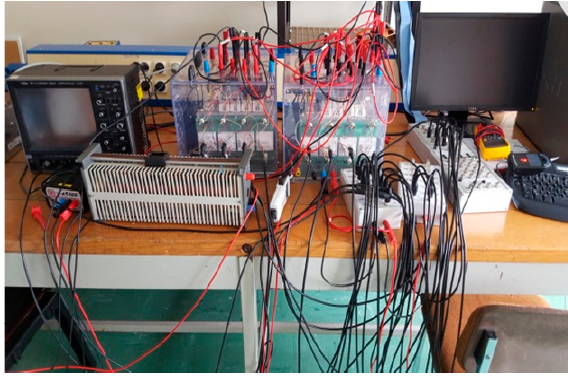
Figure 19. Experimental test bench.